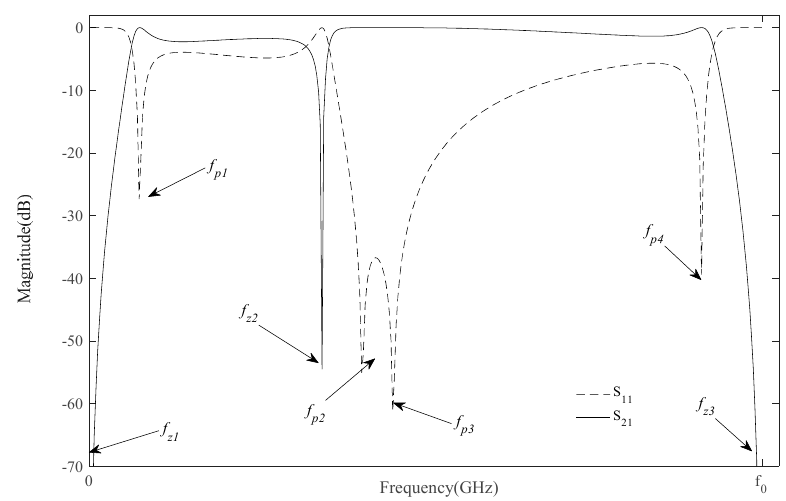
Figure 2. Calculated frequency responses of the ideal circuits shown in Figure 1.